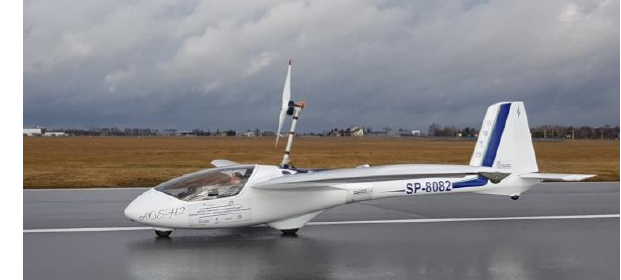
Fig. 2. The AOS H2 motor